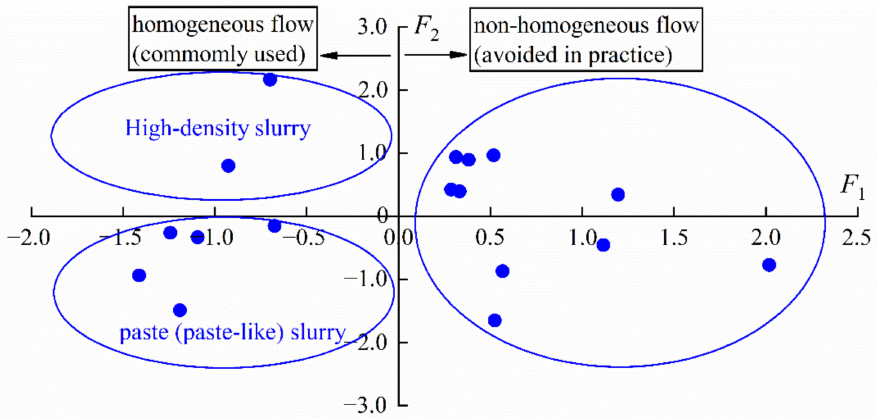
Figure 7. Identification of the new indices for the slurry flow.